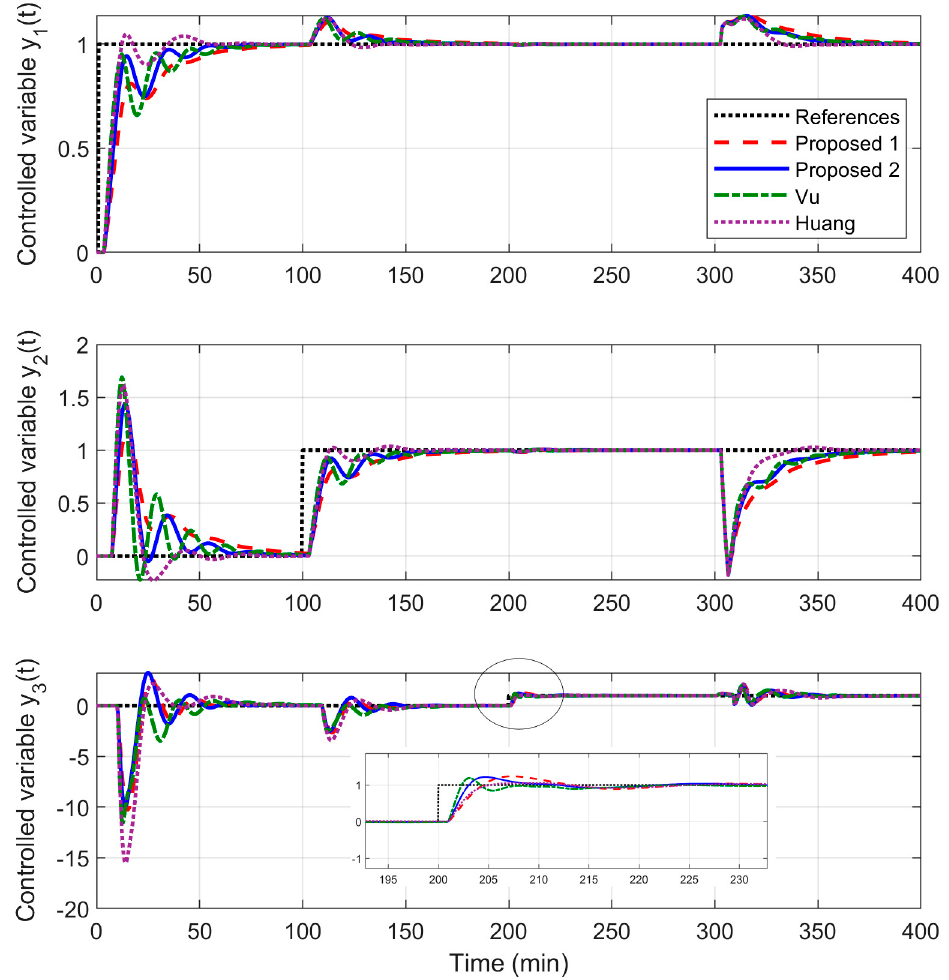
Figure 14. Closed loop system responses of controlled variables in example 2.